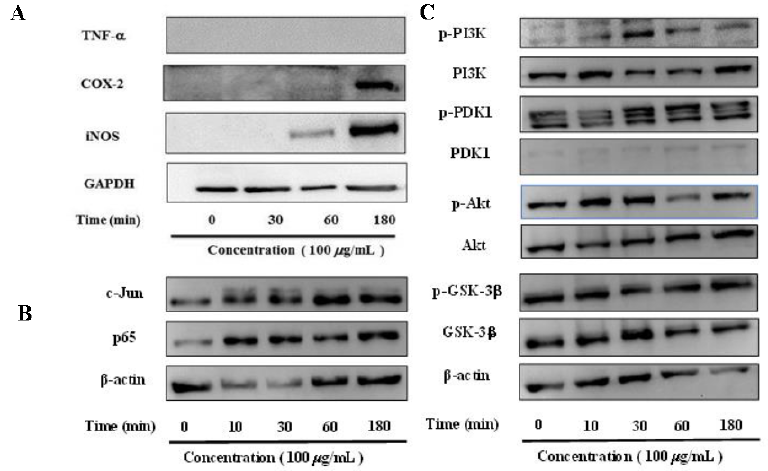
Figure 5. ( A ) The effect of polysaccharide on the protein expression of iNOS, COX-2, and TNF. ( B ) The effect of polysaccharide on the translocation of transcription factors in RAW264.7 cells. ( C ) The effect of polysaccharide on the PI3K/AKT signaling pathway in RAW264.7 cells.